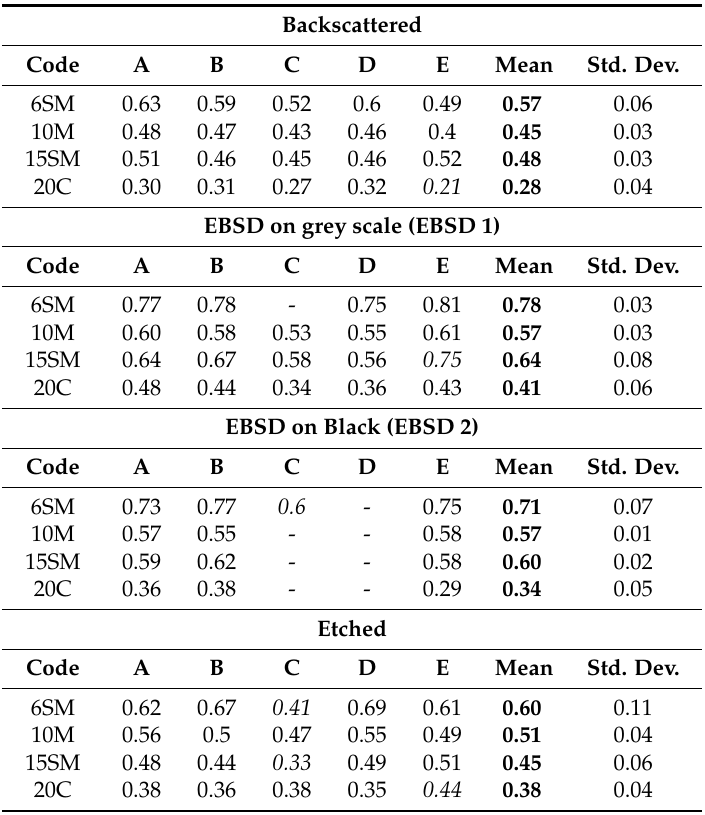
Table 2. Contiguity measurements on all four hardmetal grades from five participants A–E. Blank cells indicate no measurement reported by participants. Outliers (more than 1 standard deviation from the mean indicated by